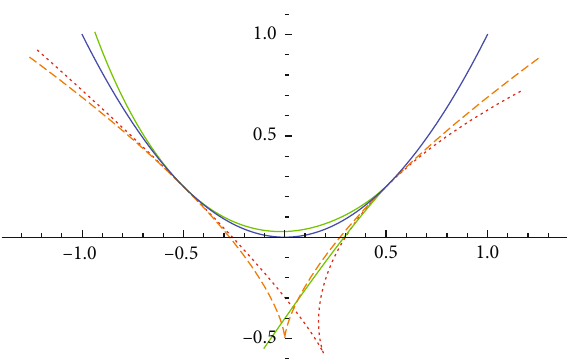
Figure 1: The mixed-type curve (blue) and the evolutoid (evolute) of it.